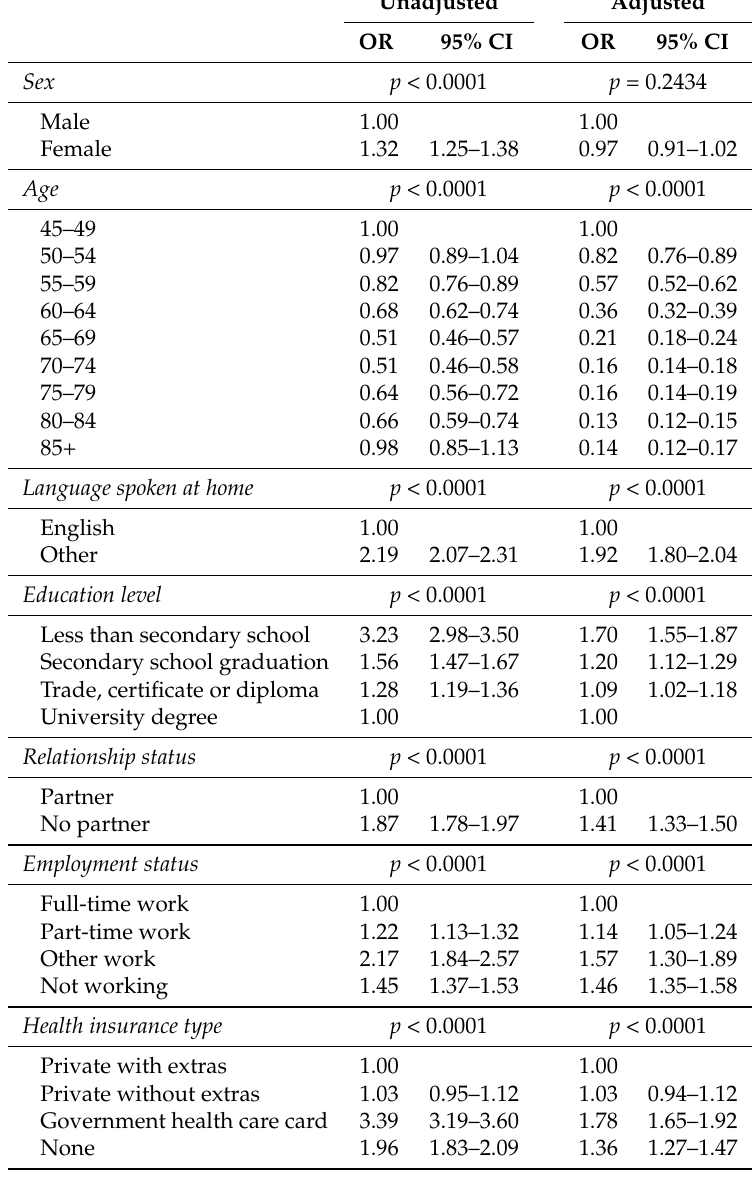
Table 3. Unadjusted and fully-adjusted odds ratios for individual-level adjustment variables.